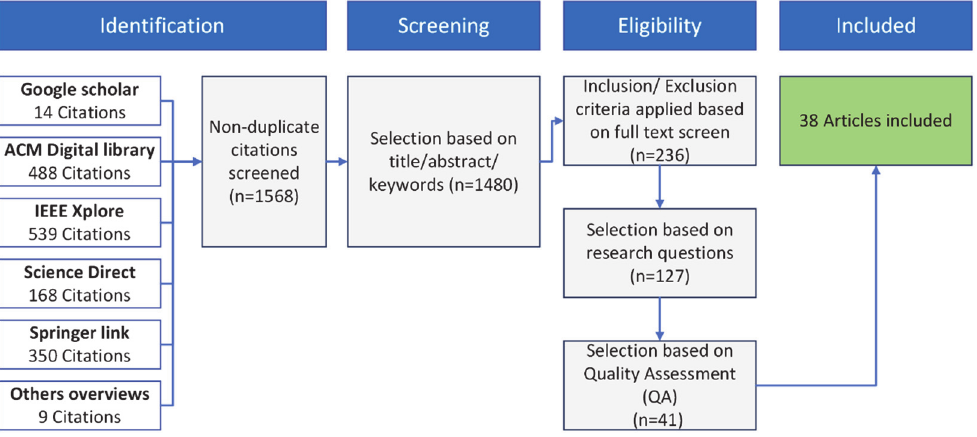
Figure 2. PRISMA flow chart of the study